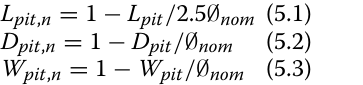
width were assumed as the nominal bar diameter, i.e.